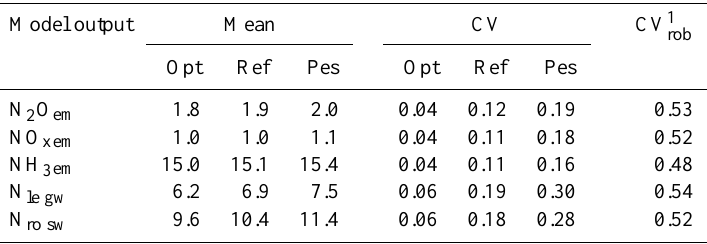
Table 8. Effect of optimistic and pessimistic scenarios on the overall mean (in kg N ha − 1 yr − 1 ) and CV in the EU27-average N 2 O emission, NO x emission, NH 3 emission, N le groundwater and N ro surface water for the year